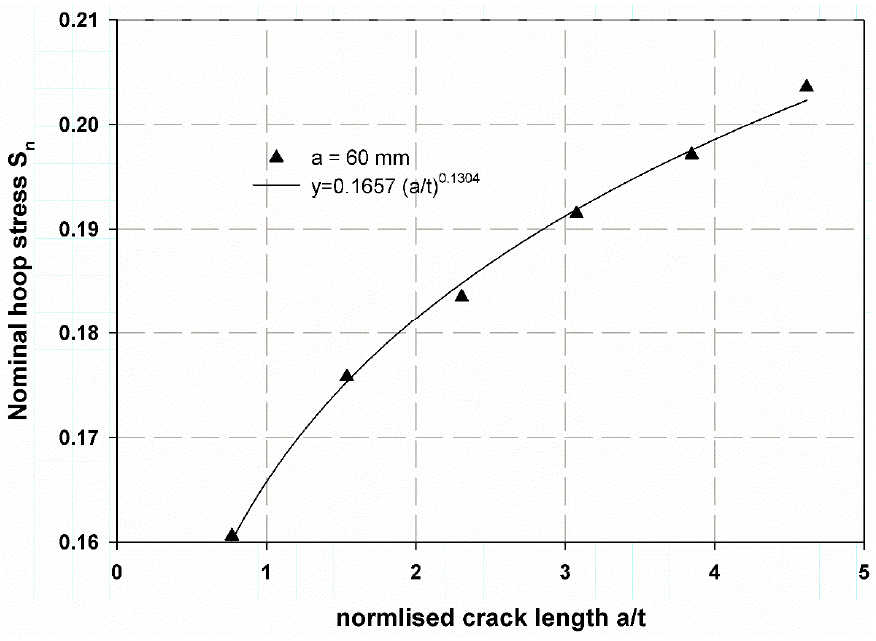
Figure 13. Nominal hoop stress versus the normalized crack length.